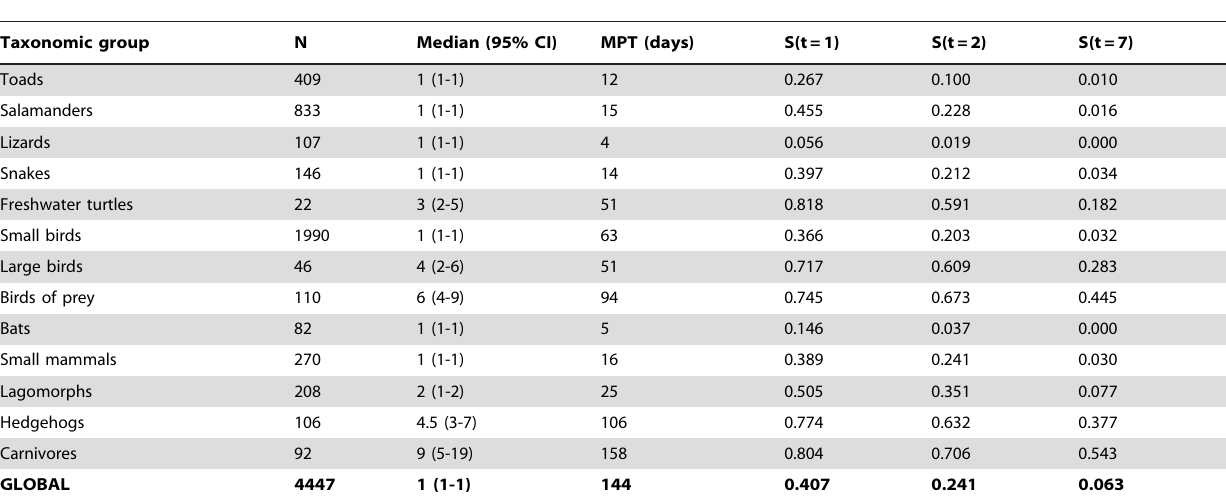
Table 1. Summary of results for persistence estimates for each taxonomic group and the ‘‘all taxa’’ data set (N: sample size; Median (95% CI): median persistence probabilities and corresponding 95% confidence intervals obtained with a Kaplan-Meier estimator; MPT: maximum persistence time recorded (in days); S(t =1), S(t =2), S(t = 7): estimate of persistence probability for 1-day, 2-day and 7-day intervals obtained with a Kaplan-Meier estimator).